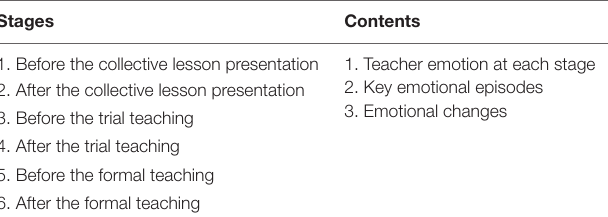
TABLE 1 | Stages and contents of the narrative framework of teacher